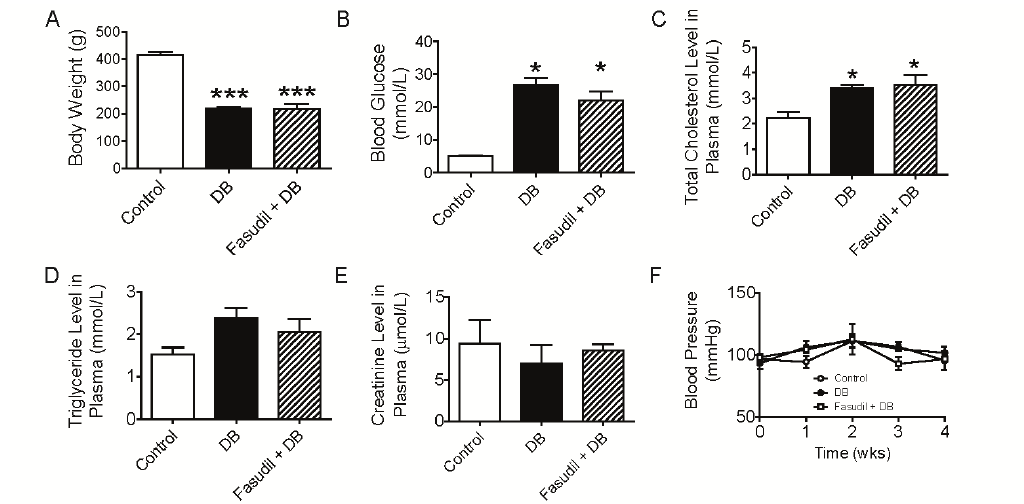
Figure 1. Effects of Rho kinase inhibition on metabolic parameters in diabetic rats. ( A ) Body weight of rats after 4-week treatment with fasudil; ( B ) Blood glucose of rats after 4-week treatment with fasudil; ( C – E ) Total cholesterol level ( C ), triglyceride level ( D ) and creatinine level ( E ) in plasma of rats after 4-week treatment with fasudil; ( F ) Blood pressure of rats during 4-week treatment with fasudil; ( G , H ) kidney weight, kidney weight/body weight ratio ( G ) and liver weight, liver weight/body weight ratio ( H ) of rats after 4-week treatment with fasudil. * p < 0.05, ** p < 0.01, *** p < 0.001 compared with control group. Data are mean ± S.E.M. from five to six different